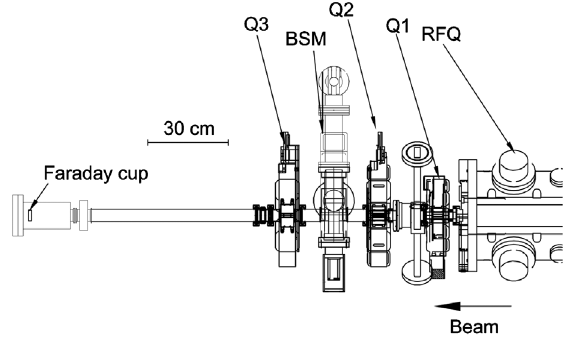
FIG. 3. Experimental setup to measure the longitudinal phase distribution using BSM in the test stand. Q1, Q2, and Q3 are quadrupole